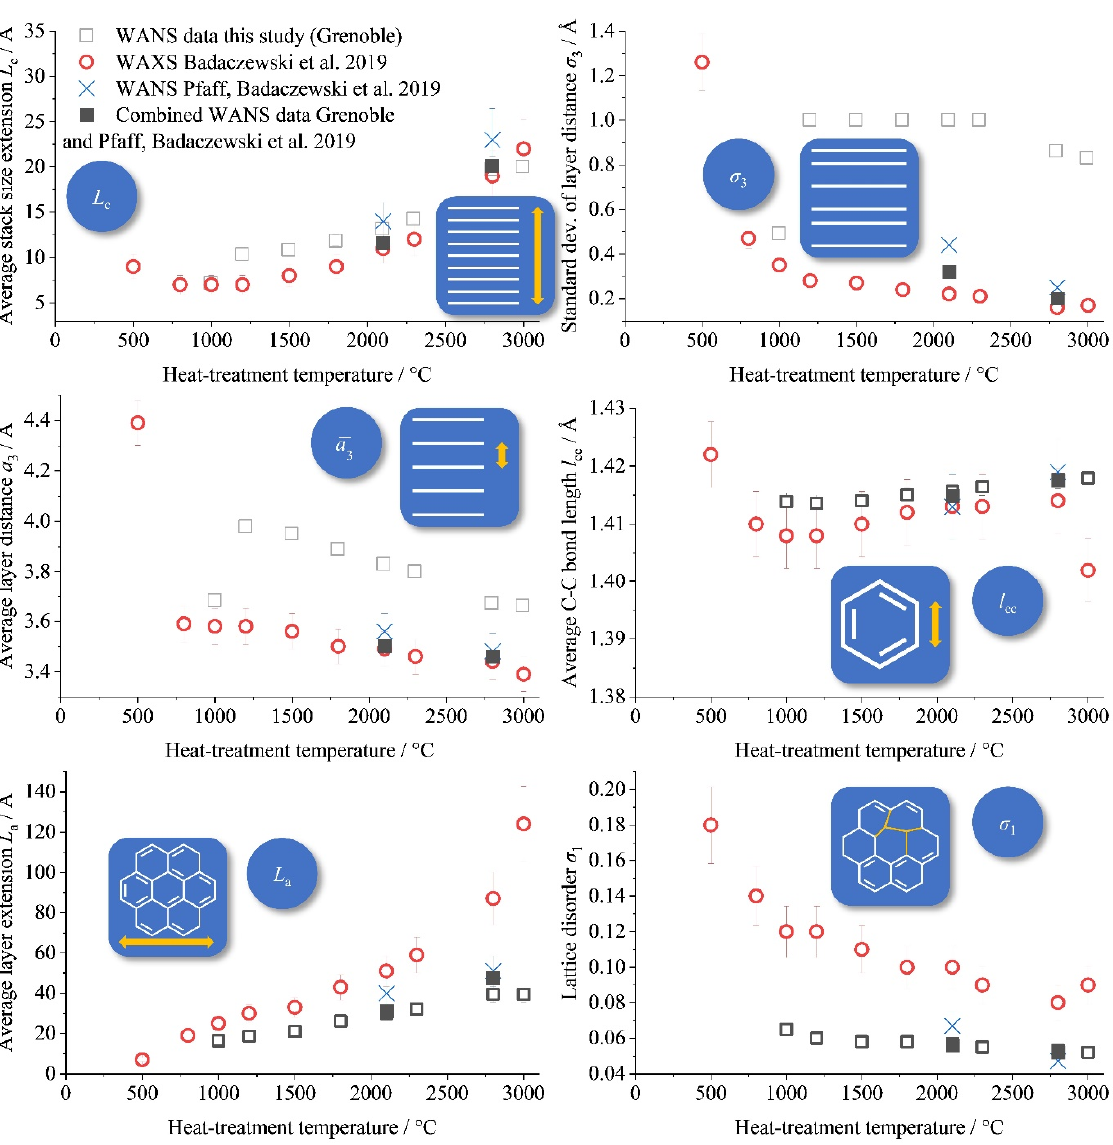
Figure 7. Microstructural parameters obtained from WANS refinement for the carbons derived from phenol-formaldehyde resin (PF-R) as precursor (black border only: this study (WANS Grenoble), red: Badaczewski et al. (WAXS) [37], blue: Pfaff et al. (WANS Berlin) [43], black filled: combined WANS data from Grenoble and Berlin). More information about the meaning of the absolute value of σ 1 can be found in the SI file in S6. The decrease in L c for temperatures between 500 °C and 1000 °C might have been caused by the release of pyrolysis gases in this temperature range, as already described previously [37]. This interpretation is supported by the quite high values of σ 3 for 500 °C.